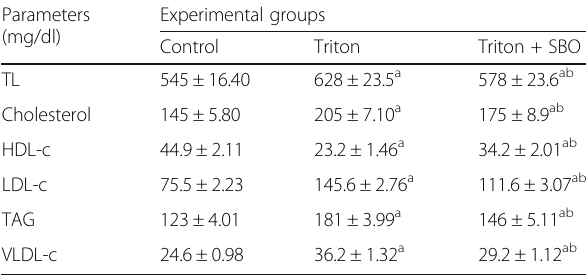
Table 5 The effect of soybean oil (SBO), Triton WR-1339 + SBO, and their combination on plasma total lipids